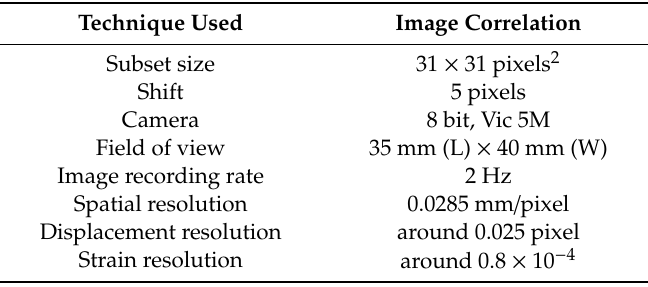
Figure 1. Specimen configuration and experimental set-up. Table 1. Details on digital image correlation (DIC)